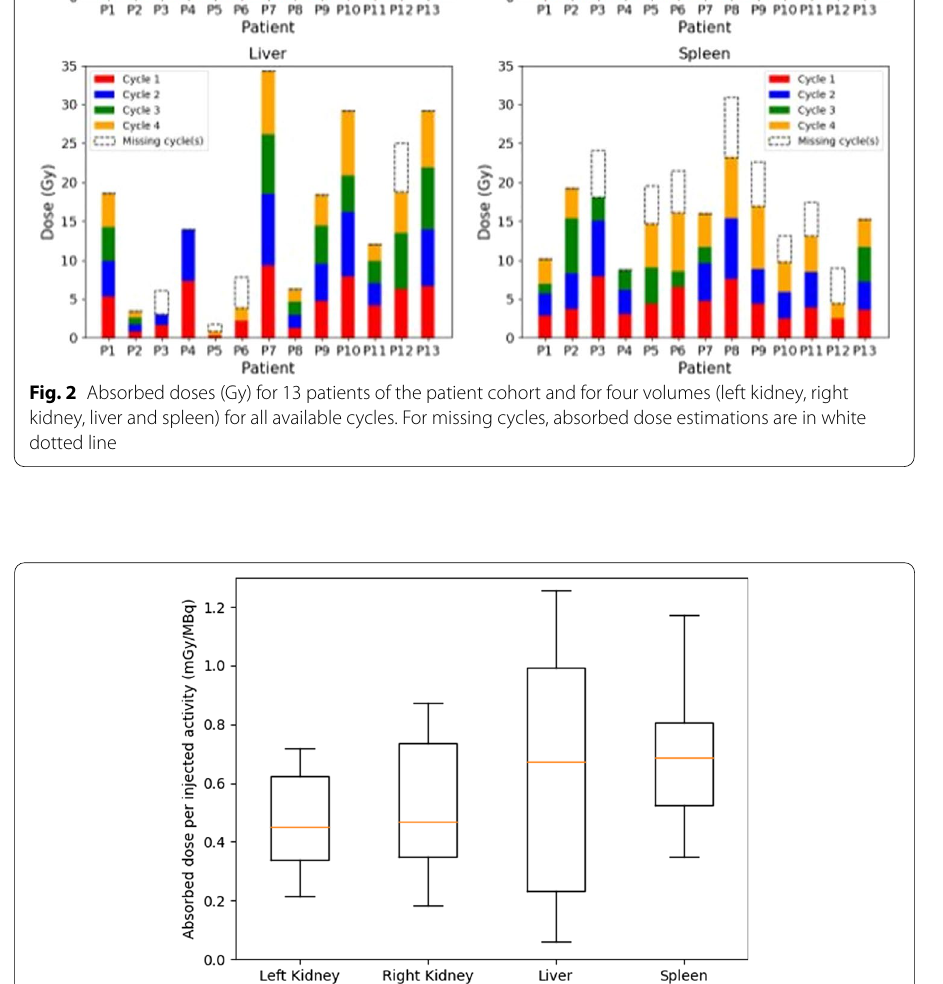
Doses per injected activity [mGy/MBq] were averaged on all cycles for each patient and are represented in Fig. 3 for the four organs. For bone marrow, doses per injected activity were given as mean mGy/MBq for L1 to L5 and 0.04